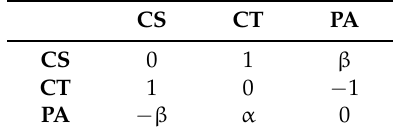
Table 2. The minimal payoff